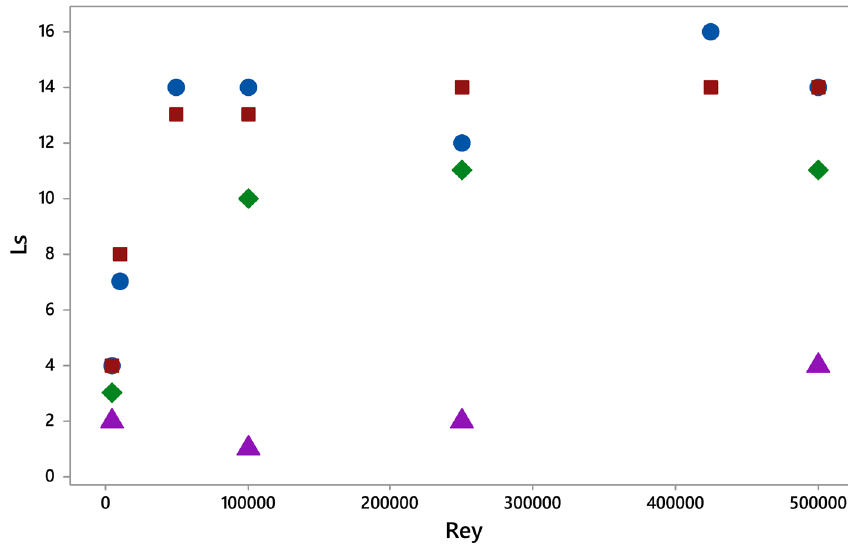
Fig. 9 Distances ( Ls ) in which each Setup reached 5° for the swirl angle in function of the Reynolds number. ● Setup 1; ■ Setup 2; ♦ Setup 3; ▲ Setup